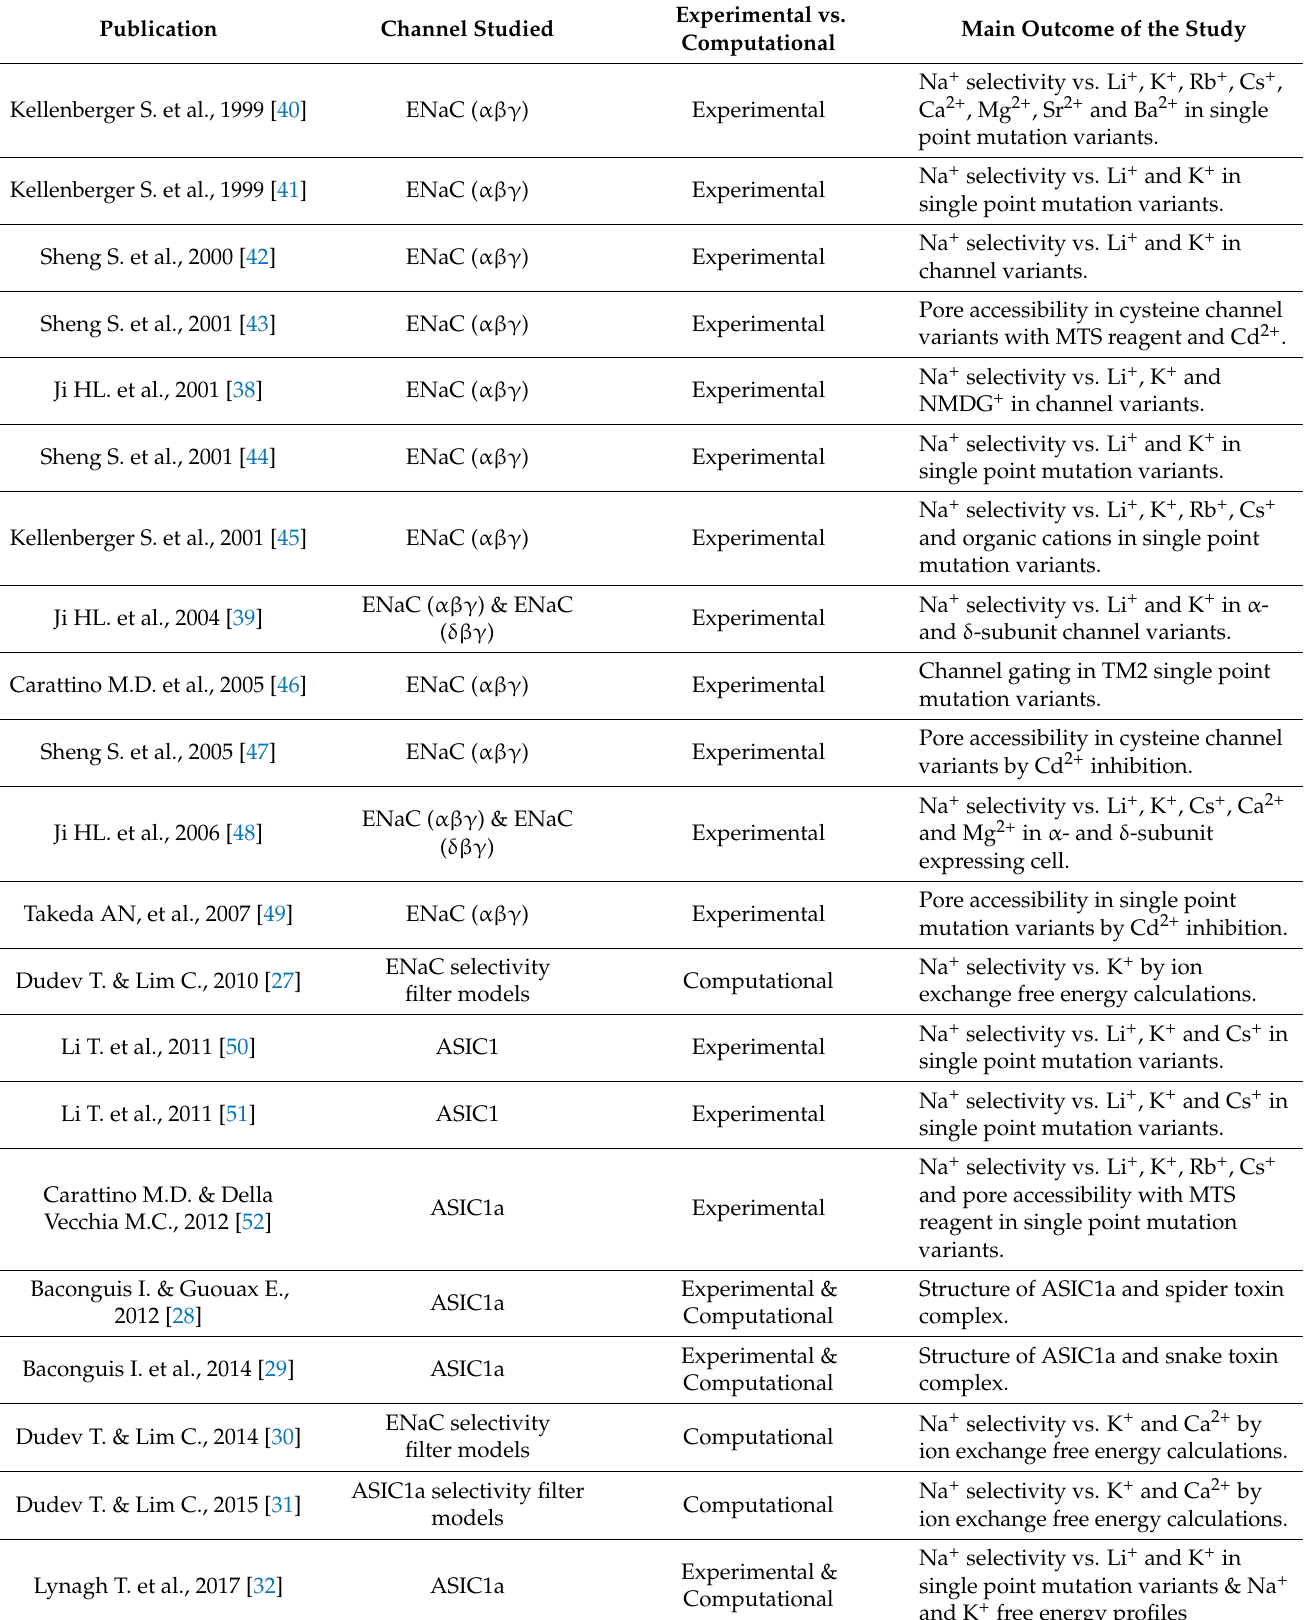
Table 1. Table summarising the papers analysed for this review . All 27 papers are listed here by date of